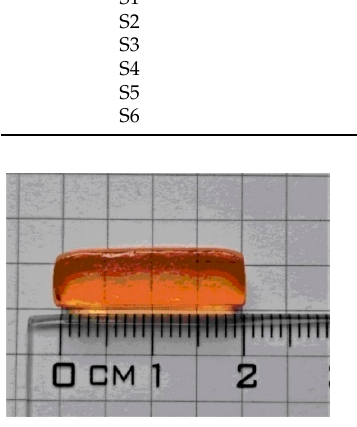
Figure 9. Tellurite glass after